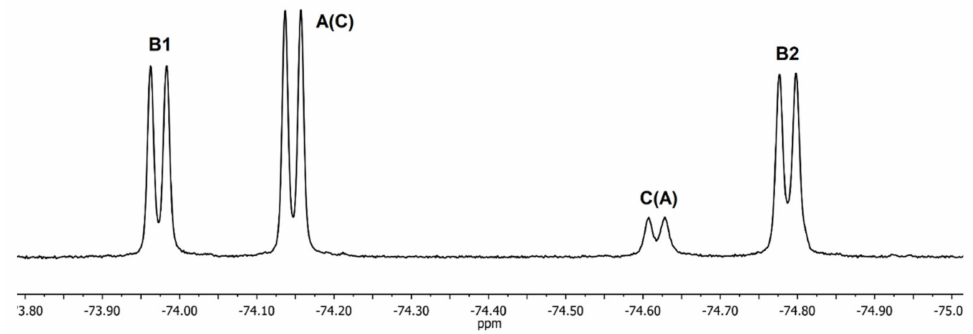
Figure 9. 19 F NMR spectrum of racemic 1 in CDCl 3 at 23 ◦